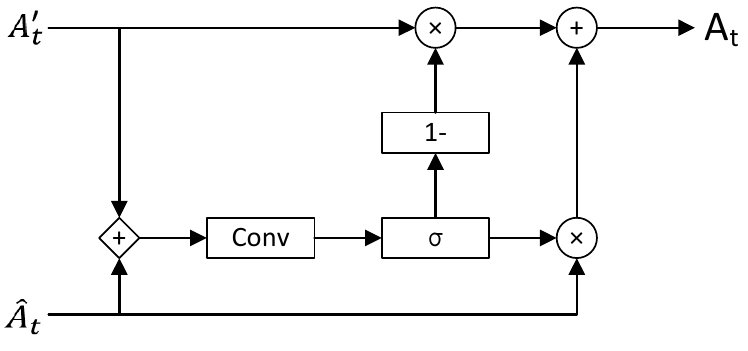
Figure 3. Update network